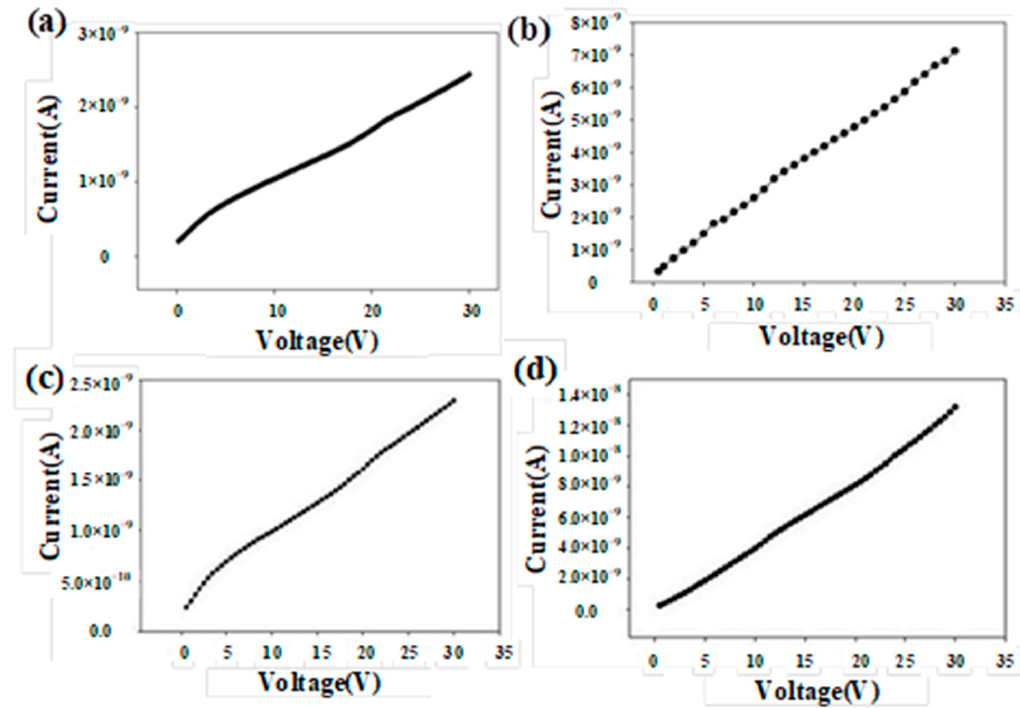
Figure 7. Reverse IV curves of ( a ) 300 µ m-thick ( b ) 100 µ m-thick PIN detector ( c ) typical bonded 300 µ m and ( d ) 100 µ m-thick PIN detector structure